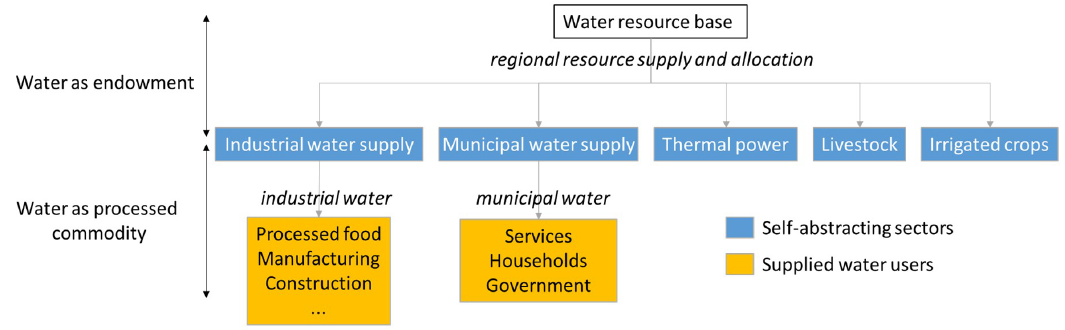
Figure 1. Water classification in the RESCU‐Water model.